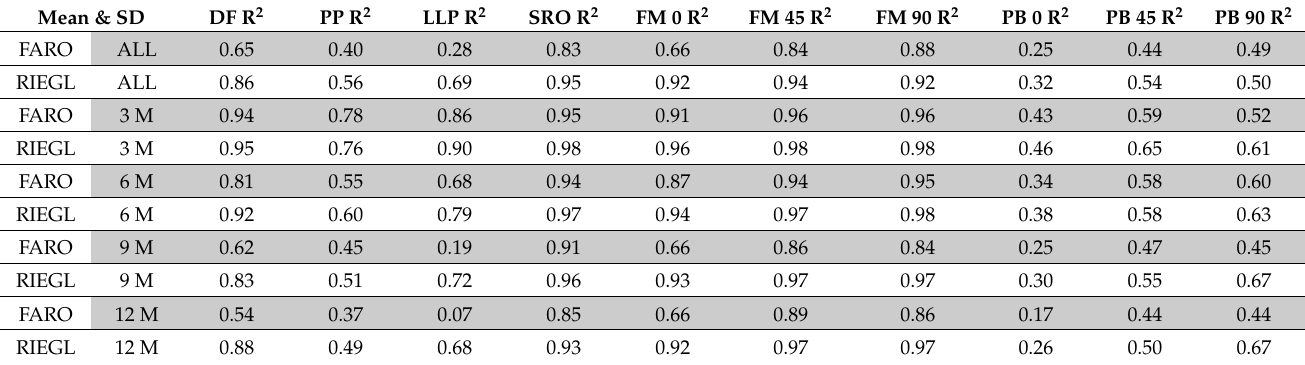
Table 4. Coefficient of determination values for multiple linear regression models across sample types. Mean intensity values of each sample and the standard deviation of each sample revealed the best fitting model. The figures 0, 45, and 90 indicate the sample angle relative to the ground. A more comprehensive table is presented in Supplementary Table